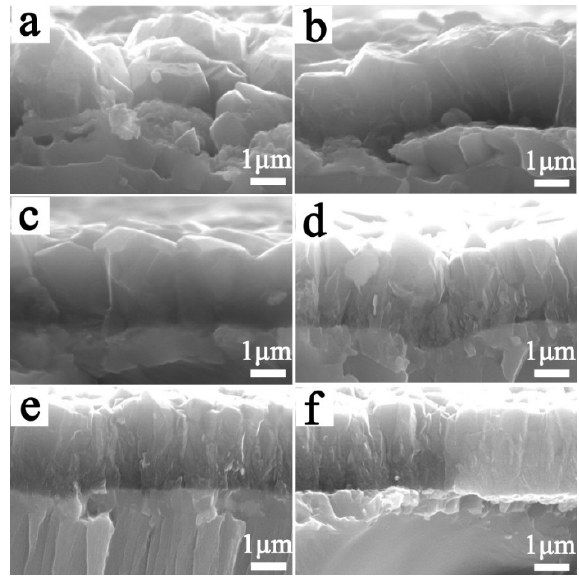
Figure 2. Cross-section morphology of the Ti / BDD samples prepared with a CH 4 flow rate of ( a ) 5 sccm;